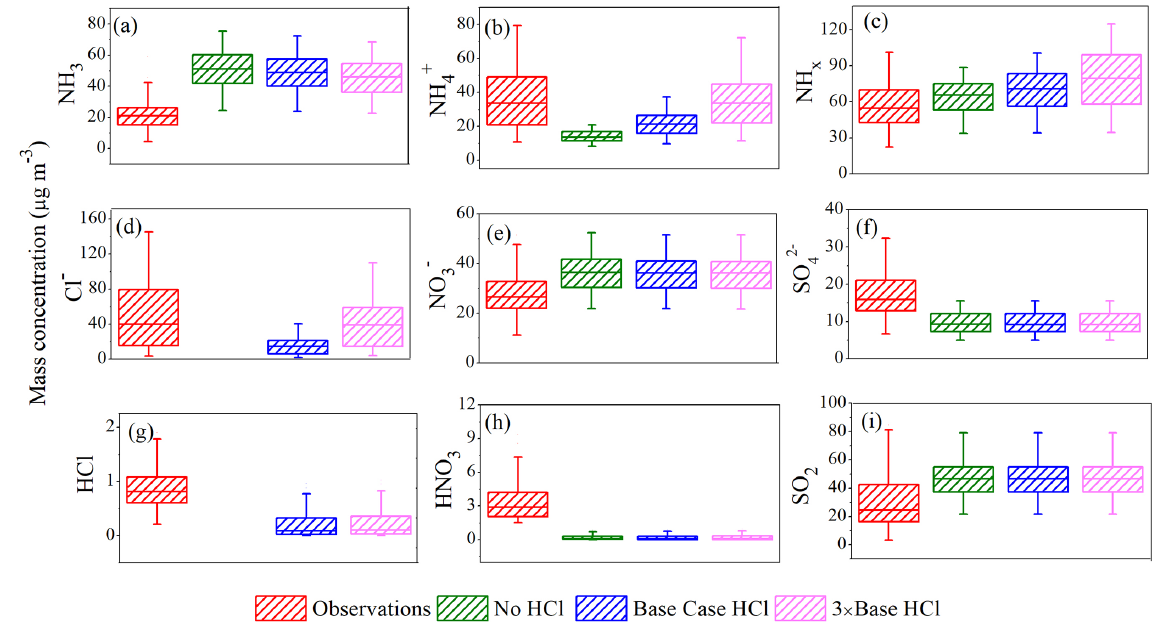
Figure 7. Box-and-whisker plot for trace gases and secondary inorganic aerosols from the observations (MARGA) and simulated in sensitivity test with changes in HCl emissions in no HCl (0molkm − 2 h − 1 ), base case HCl (24.8molkm − 2 h − 1 ), and 3 × base HCl (74molkm − 2 h − 1 ) runs at IGIA,